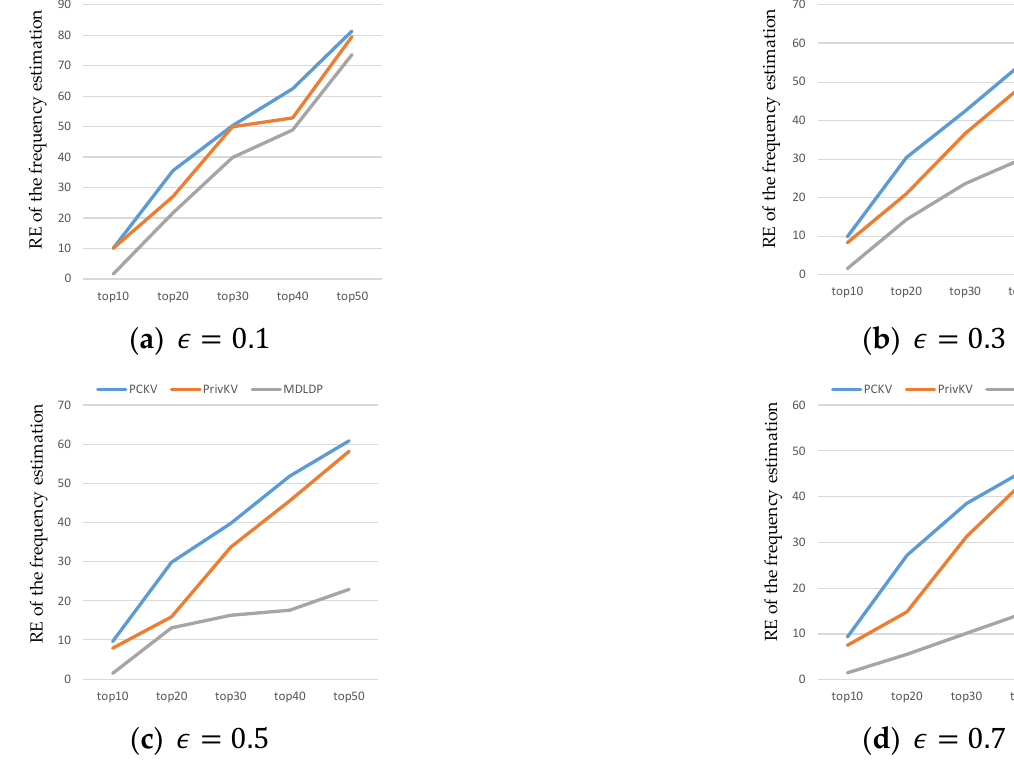
As shown in Figure 12, we compared the running times of the three algorithms under different privacy budgets (cid:101) of [ 0.1, 0.3, 0.5, 0.7 ] . It can indicate that the three algorithms have similar running times on the current experimental dataset, and the proposed algorithm performs better in frequency estimation and mean estimation with a similar run time to the other algorithms.